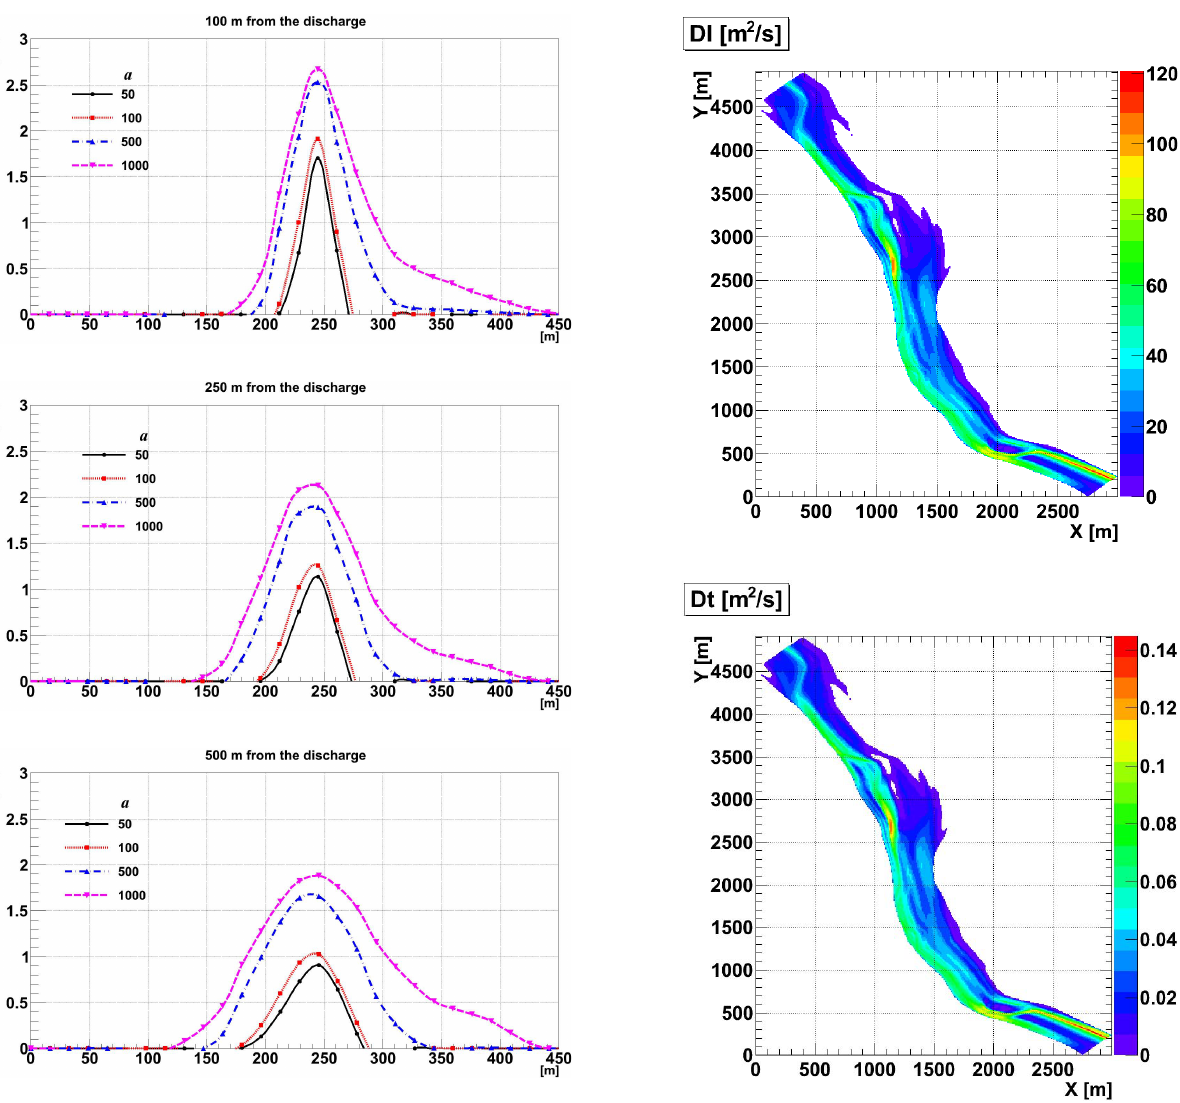
Fig. 8. The longitudinal D L and transverse D T dispersion coeffi- cients for the considered reach of the Vistula River, computed for the local values of river depth and bed shear velocity.